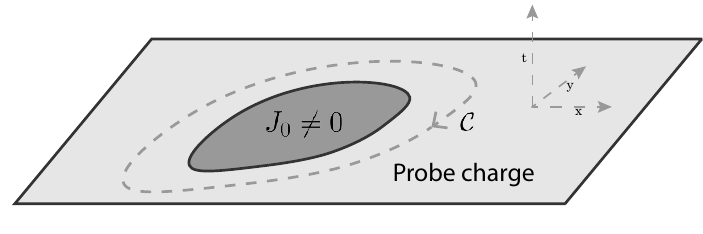
Figure 1. Non-trivial Wilson loops C enclosing charge density, giving rise to Aharanov-Bohm type e(cid:11)ects on test